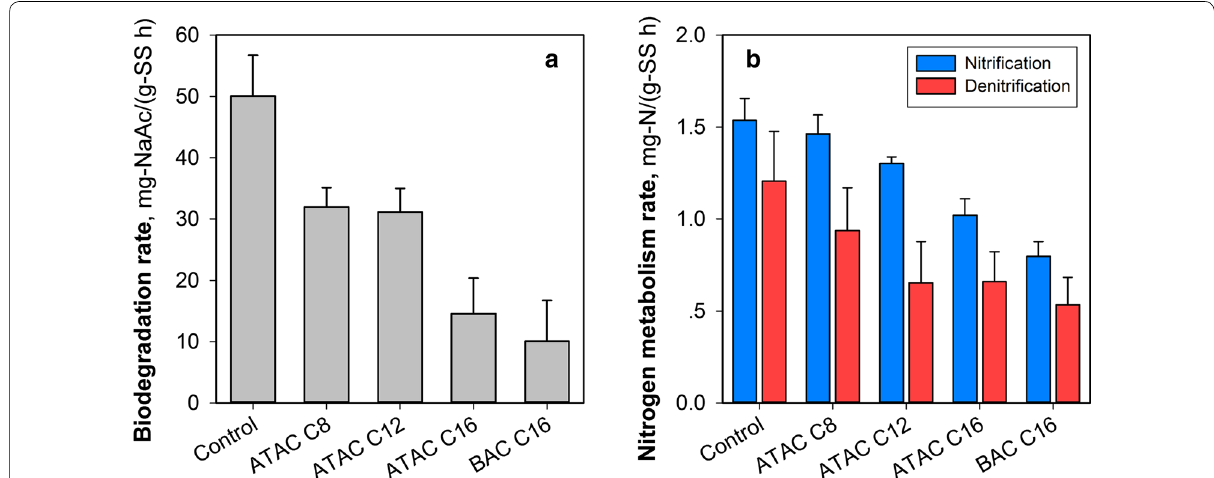
Fig. 1 a Biodegradation rates and b nitrogen metabolism rates of the microorganisms from an MBR following exposure to different kinds of QACs. Experimental conditions: QAC dosage 0.015 mmol/g-SS and exposure duration 2 h. Tests were conducted at least in = =